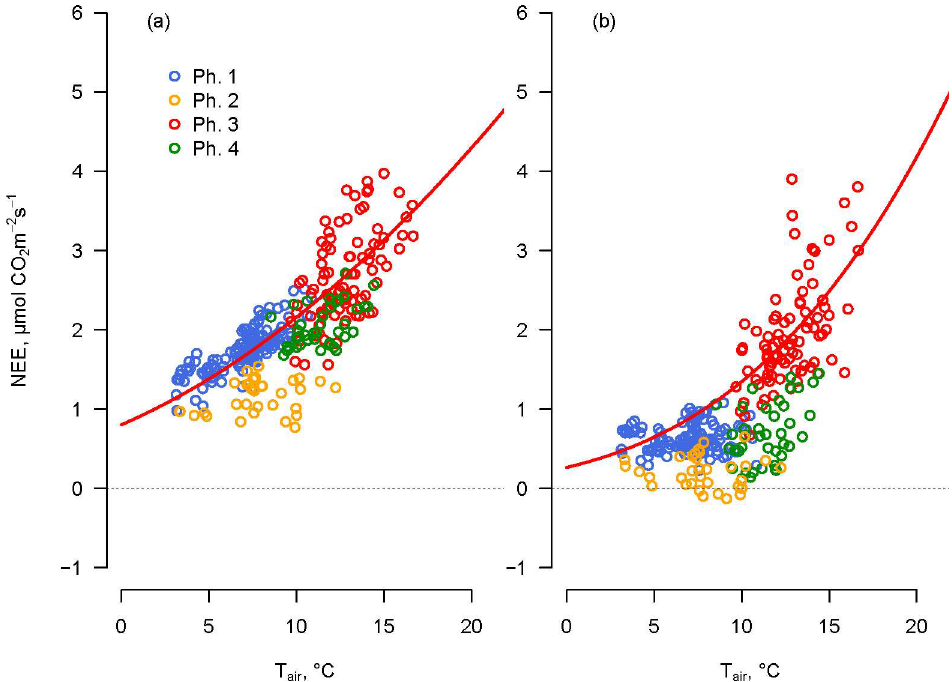
Fig 4. Net ecosystemexchange (NEE) of (a) Festuca and (b) Sempervivum measuredwith opaque chambersas a function of air temperature. Data reportedcorrespondto a week of measurements in 2012 (7 August 2012–14August 2012). Each colour of the dots indicatesone of the four “Osmond phases”in which the flux was measuredaccordingto Fig 2. The four phases are presented for Festuca plots only with the purposeof simplifyingthe comparison betweenthe two plants in the same time ranges. The solid red line represents the modelled NEE responseto temperature obtainedby applyingEq (2) only on data of phase3, when we assumed that no CO 2 uptake was occurringin the Sempervivum